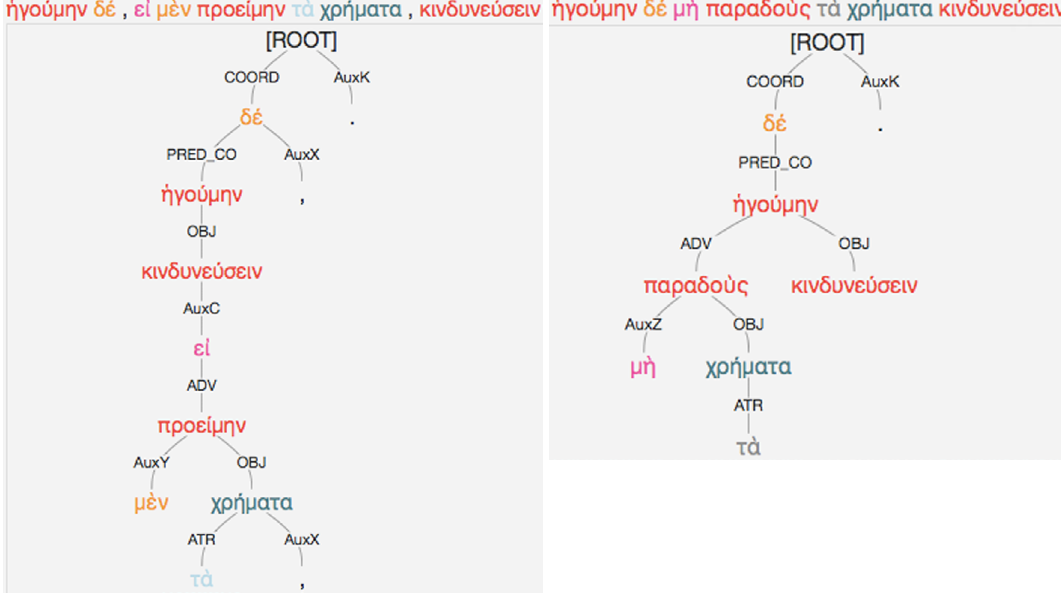
Fig 2. Syntactical comparison of Isocrates’ (left) and Dionysius’ (right)